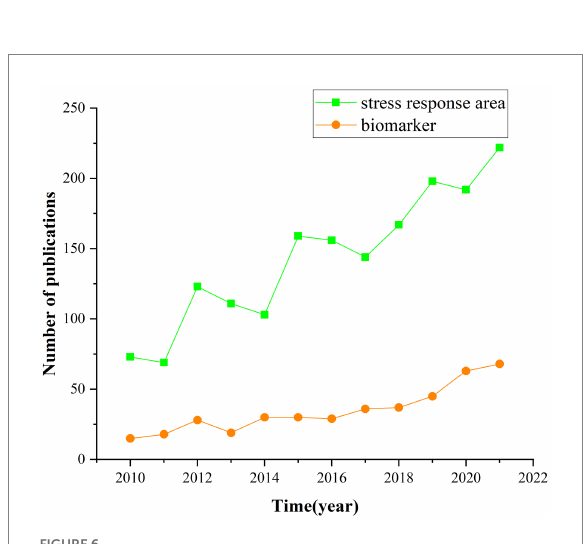
FIGURE 6 Annual articles number of SRA and